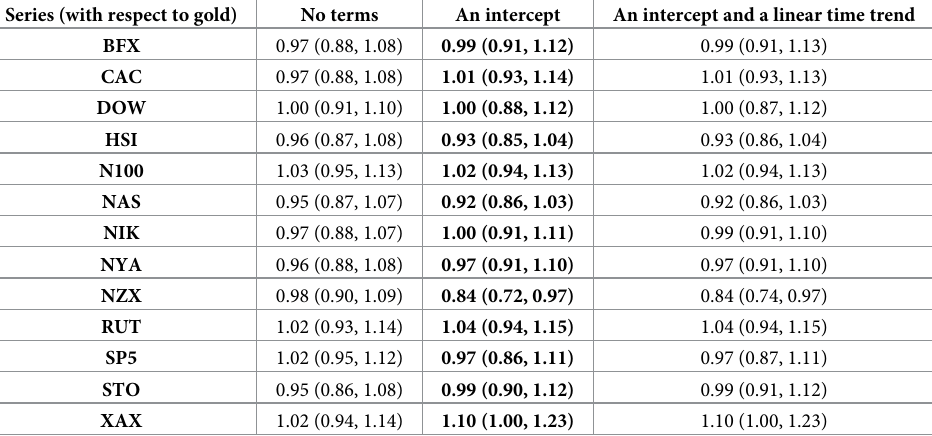
Table 3. Estimates of d for the GOLD differential. Sample ending in June 2022. Series (with respect to